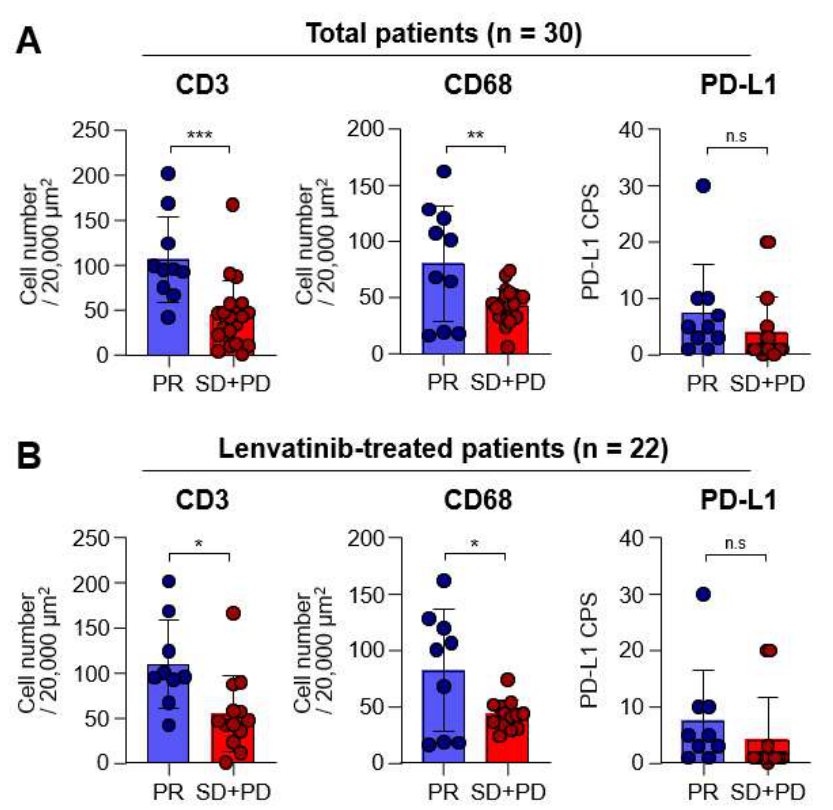
Figure 2. Differences in the expression of each marker according to the best responses. Graph showing the objective response rates of total ( n = 30) and lenvatinib ( n = 22) groups. ( A ) Graphs showing the CD3+ and CD68+ cell numbers, as well as the programmed cell death-ligand-1 (PD-L1) combined positive score (CPS) in total patients with partial response (PR; n = 10) and stable disease (SD) plus progressive diseases (PD; n = 20) in the total group. ( B ) Graphs showing the CD3+ and CD68+ cell numbers, as well as PD-L1 CPS, in lenvatinib-treated patients with PR ( n = 9) and SD plus PD ( n = 13). n.s., not significant; * p < 0.05; ** p < 0.01; *** p < 0.001. Furthermore, we observed a positive correlation between PD-L1 CPS and CD68 ex- pression (r = 0.39, p = 0.01), indicating that CD68+ macrophages might be an important PD-L1-expressing population. It is worth noting that more intratumoral CD68 expression was found to be associated with the presence of extrahepatic metastasis (r = 0.42, p = 0.02). These findings suggest that CD3, CD68, and PD-L1 expressions might not be significantly affected by tumor-related factors, except for the presence of extrahepatic metastasis. In ad- dition, we analyzed the expressions of CD3, CD68, and PD-L1 based on viral and non-viral etiologies (Figure 3B). As a result, no difference was observed between the viral (n = 19) and non-viral subgroups (n = 11) in the expression of CD3, CD68, and PD-L1, suggesting that these markers may not be influenced by the etiologies of